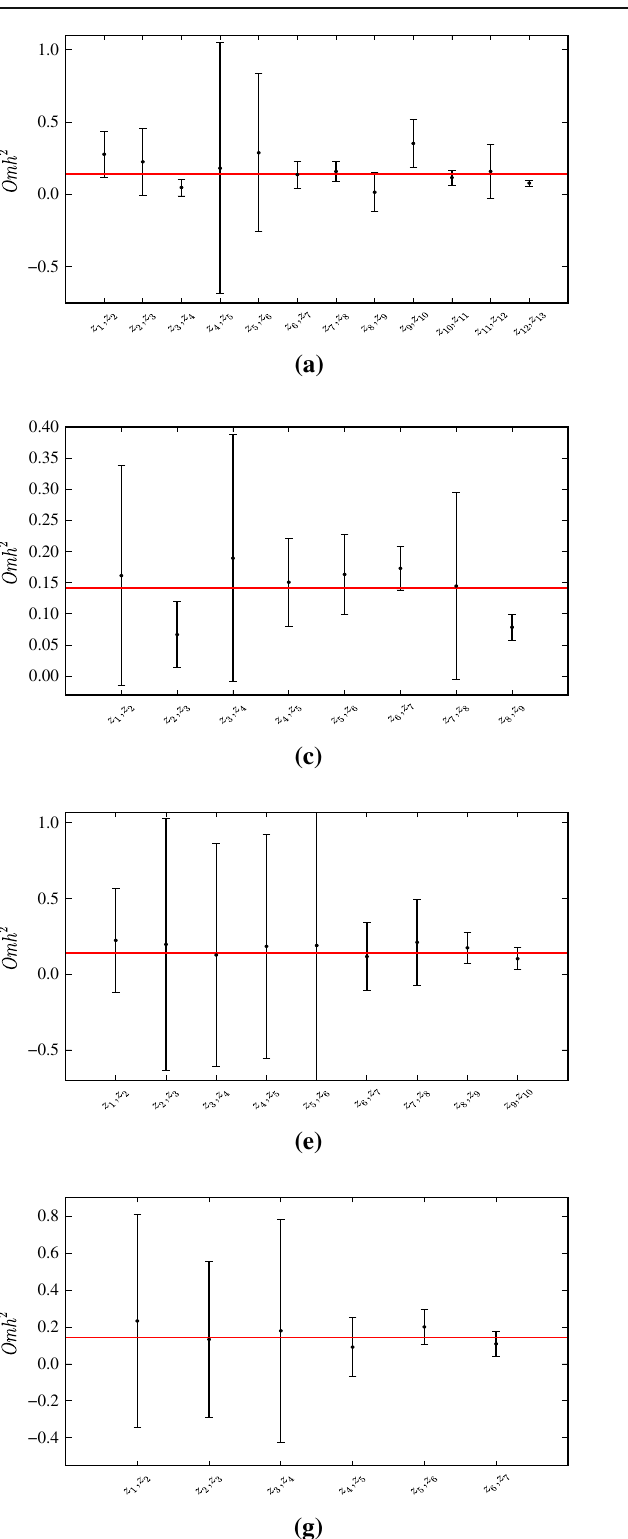
statistics3–4,4–5,4–5–6and4–6–7measurementsperbincase,respec- tively, where the red lines represent the best-fit value of Omh 2